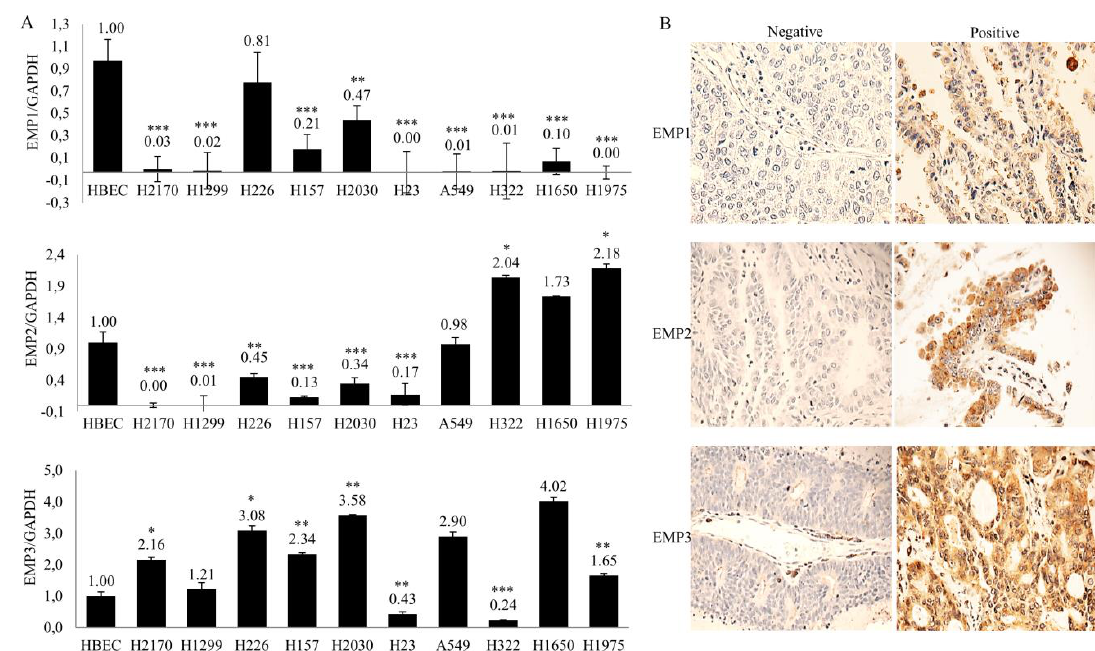
Figure 1. Expression analysis of epithelial membrane proteins (EMP) 1-3 in non-small cell lung cancer (NSCLC). ( A ) Analysis of EMP1-3 mRNA expression in 10 NSCLC cell lines by real-time RT-PCR. Gene expression in comparison to the housekeeping gene (GAPDH) expression in normal bronchial epithelial cells (HBECs) was set to 1.0. The data are shown as the means of three independent experiments ± standard deviation. * p < 0.05, ** p < 0.01, and *** p < 0.001 when analyzed with Student’s t -test. ( B ) Representative expression of EMP1-3 proteins in primary lung tissues (magnification ×400) using immunohistochemistry with negative staining (score 0; top) and strong staining (score 3; bottom). Table 1. Correlation between EMP1 expression and clinicopathological data in primary lung tu-